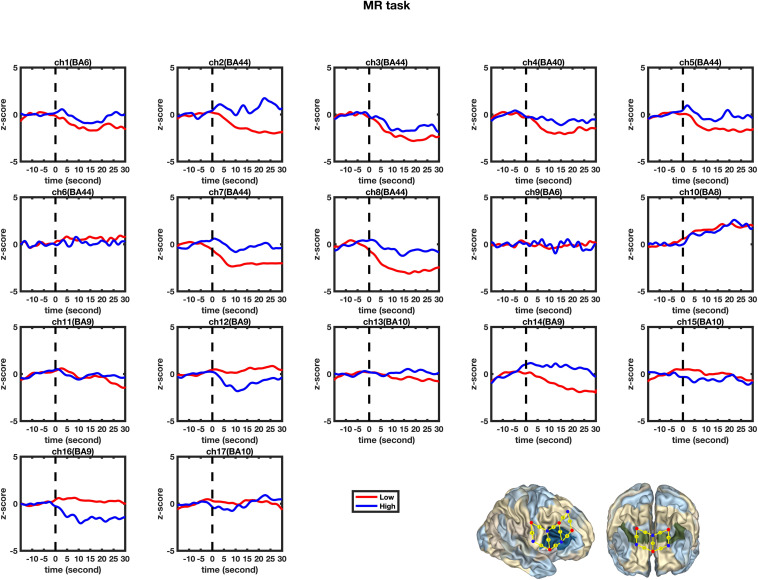
Temporal changes in the HbO concentration in the 17 channels during the mental rotation tasks. From left to right are channels 1–17. The HbO data for Low-MWC (N1 = 18) and High-WMC (N2 = 9) are shown in the blue and red lines, respectively.